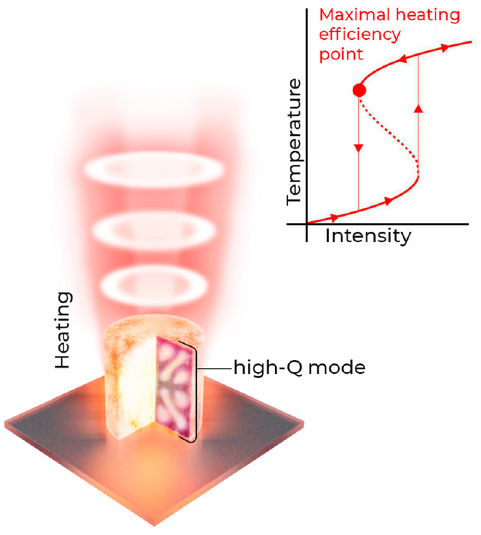
Figure 1: A schematic illustration of the main idea: optical heating of the nanoresonator leads to a spectral shift of the mode frequency inducing strong thermooptical nonlinearity. As the result, the bistable state can be achieved allowing for further efficient heating in the nonlinear critical coupling